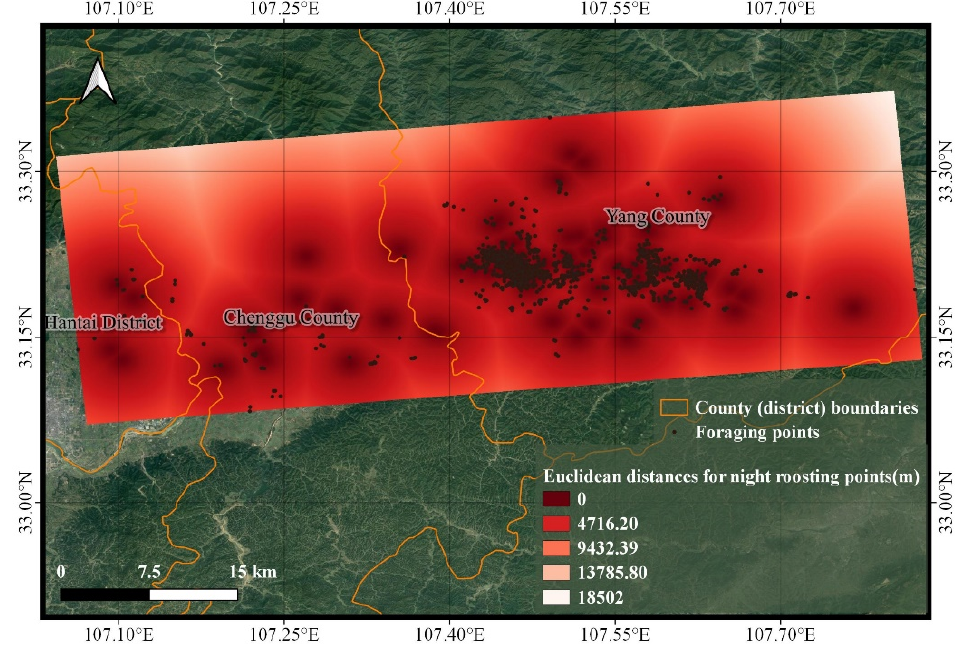
Figure 6. Analysis of the distance between the night roosting points and the foraging points. The Euclidean-distance analysis of the night roosting points in this region shows that the darker the color of the foraging points, the closer the foraging point is to the night roosting points.